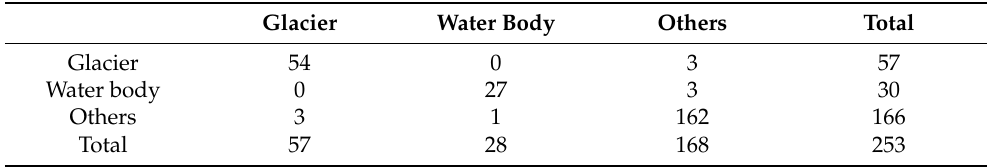
Table 4. Results of the first classification verification set.